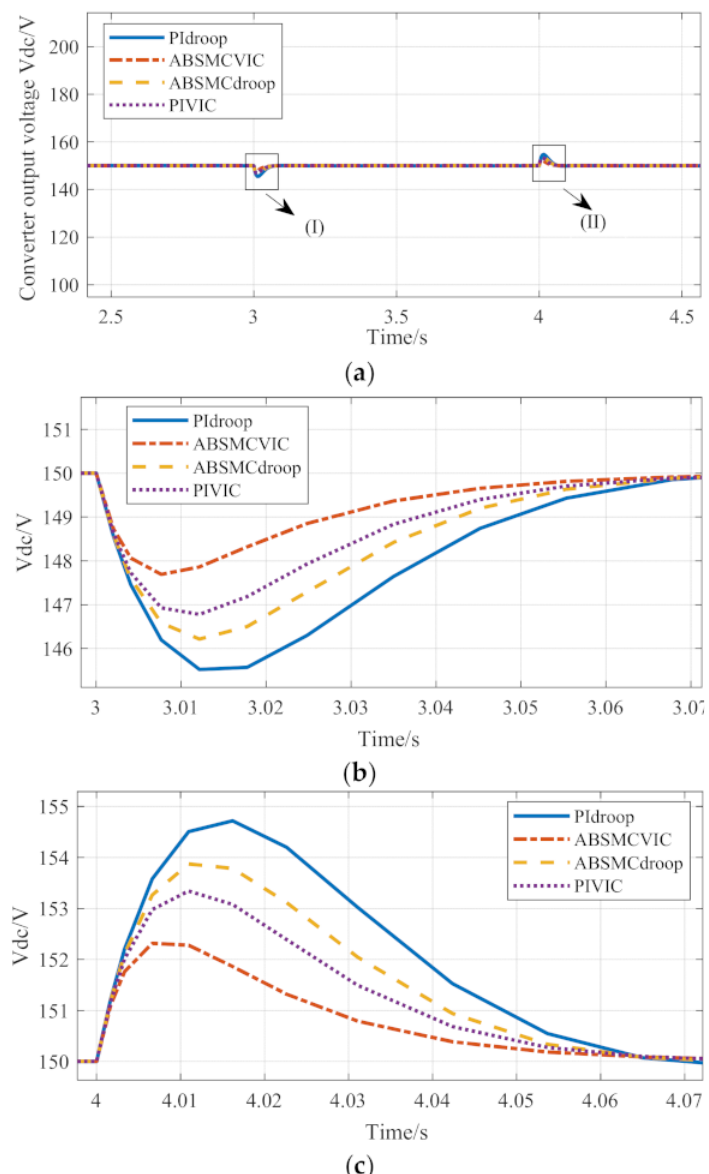
Figure 9. Cascade control method simulation. ( a ) Comparison of response performance of four cascade control methods. ( b ) Phase I comparison waveform. ( c ) Phase II comparison